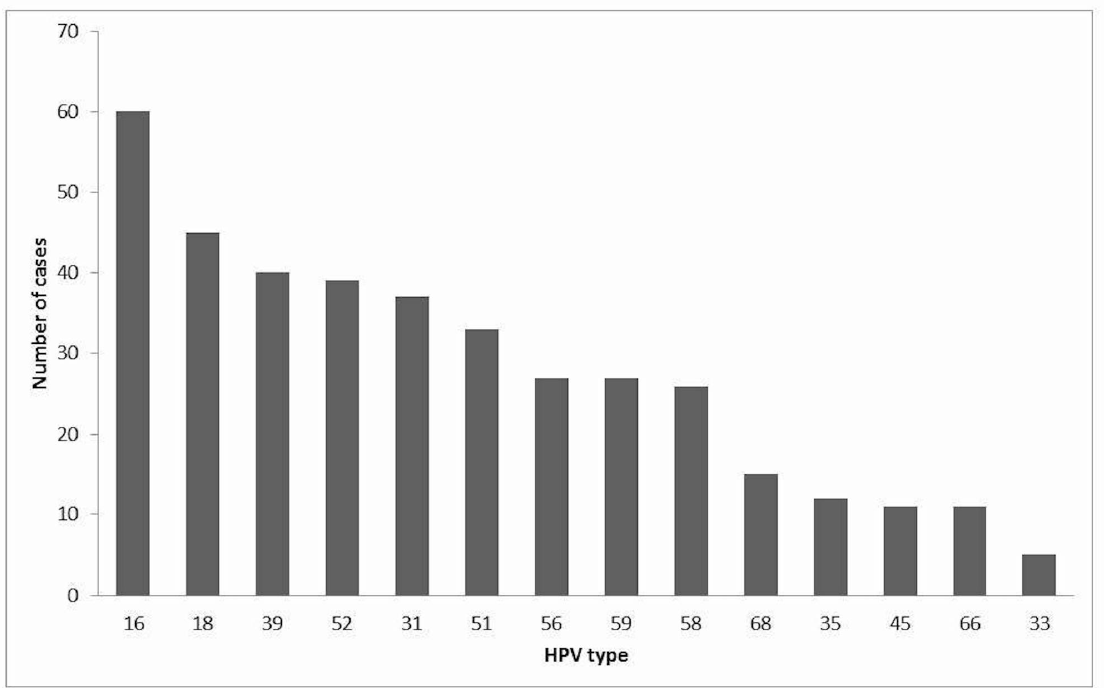
Figure 1. HPV-type prevalence found in our study group at the first consultation. We identified 378 viral sequences in 178 HPV-positive patients, of which 105 had multiple infections. The most frequent HPVs were 16, 18, 39, and 52.